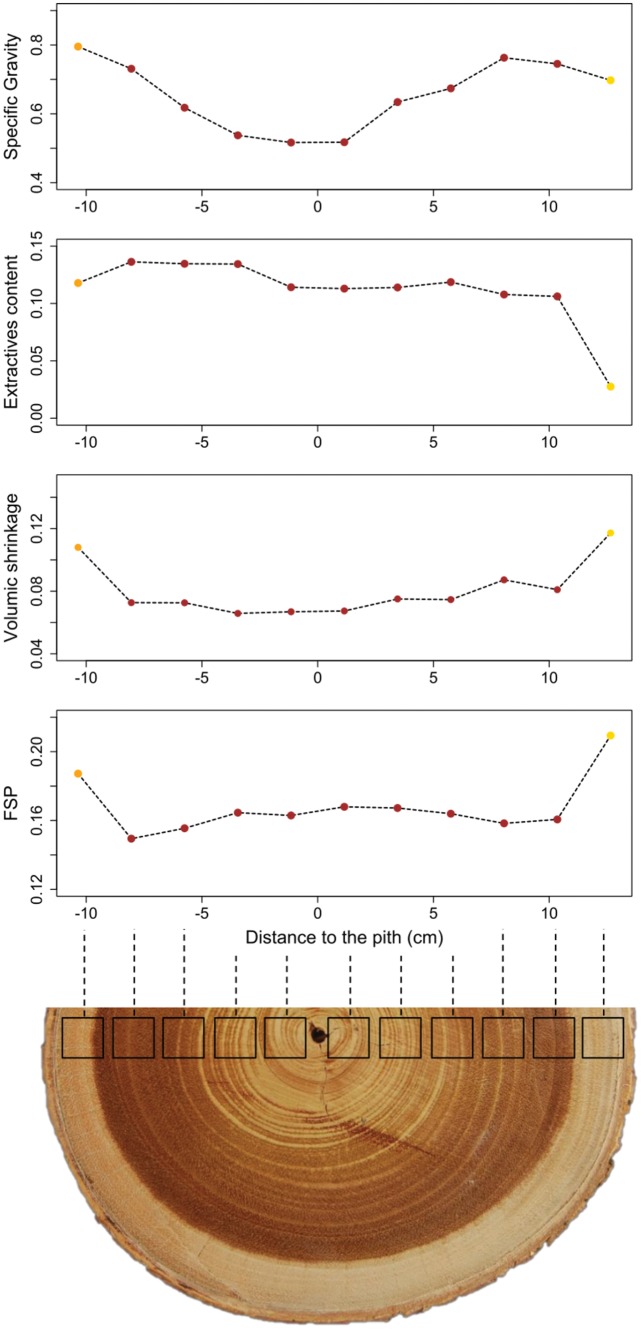
Stacked view of basic density, extractive content, shrinkage and FSP along one individual truck cross-section.